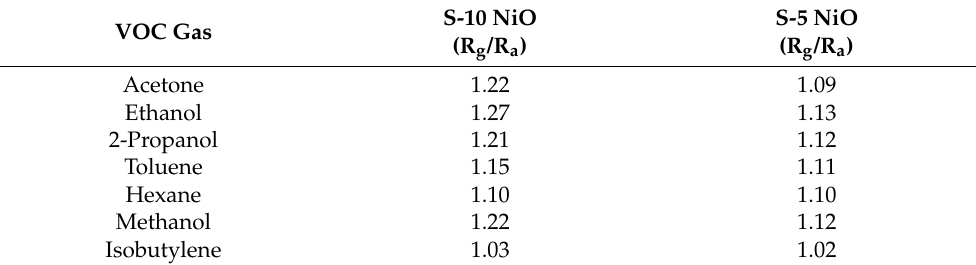
Table 1. Gas relative responses for NiO towards each VOC at 5 ppm and 350 ◦ C at 40% r.h. VOC